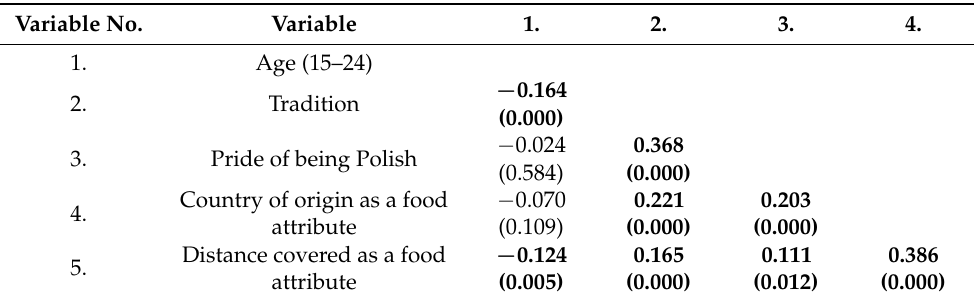
Table 11. Correlation matrix for predictors of consumer ethnocentrism in the food market used in the retrograde stepwise regression model among women. Variable